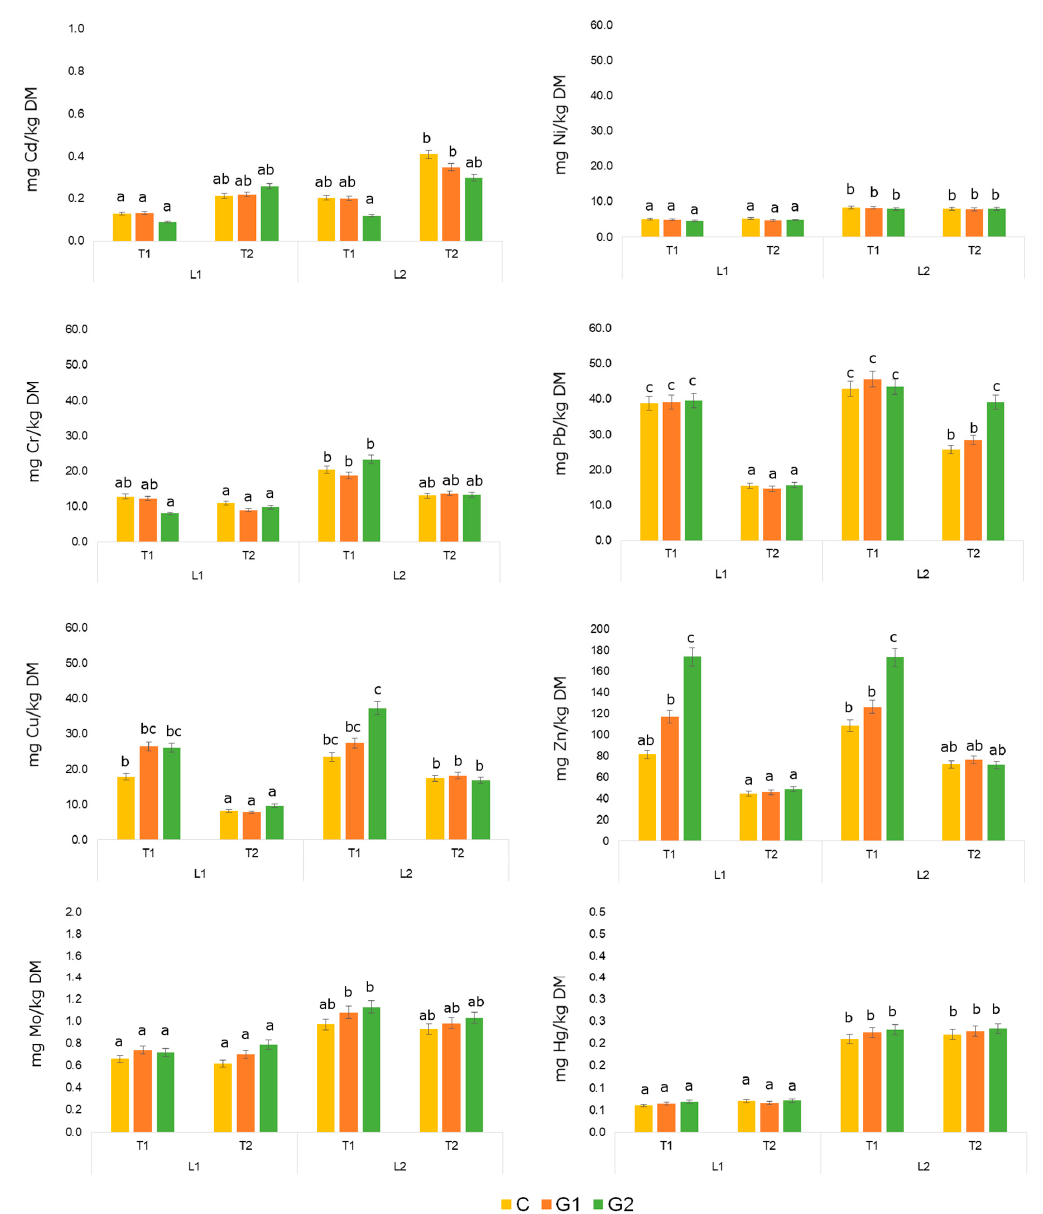
Figure 2. The average content of total heavy metals (HMs) (Cd, Cr, Cu, Mo, Ni, Pb, Zn, and Hg) in soil samples from the control plots (C) and plots fertilized with sewage sludge in a dose of 14.5 t DM/ha (G1) and 29 t DM/ha (G2) in L1 and L2, collected in the first (T1) and second (T2) year of study. Different letters above bars (mean ± SD) represent significant differences assessed with the Tukey test at p < 0.05.